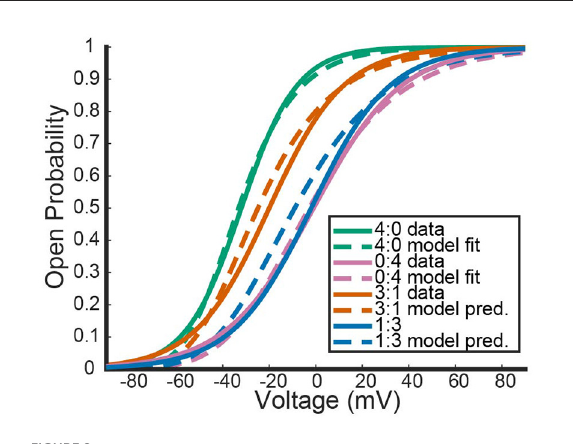
FIGURE2 Comparisons between our mathematical framework predictions for K V 1.1 / 1.2 heteromers and data from Al-Sabi et al. (2013). The solid curves are the plotted fits from Al-Sabi and the dashed curves are the results of the mathematical model. The green and pink curves correspond to the two different homomers with the dashed curve model outputs having been fit directly to Al-Sabi parameters as described above. The mean squared error (MSE) between 4:0 curves is 0.00022 and between 0:4 curves is 0.00033. The orange and blue curves are model prediction outputs for 3:1 and 1:3 K v 1.1 / 1.2 heteromers using Equations (16) and (17) for the gating kinetics. The MSE for the 3:1 curve is 0.00091 and the MSE for 1:3 curves is